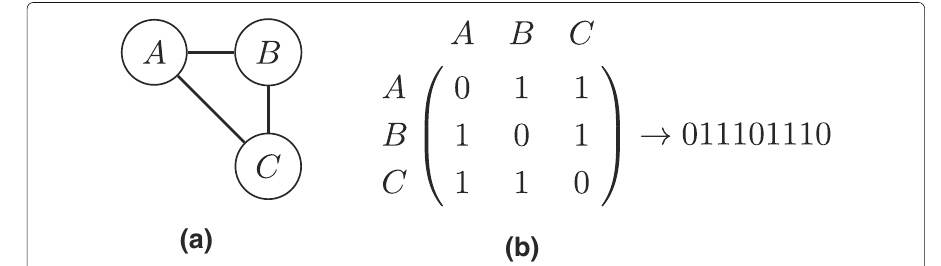
Fig. 3 Pattern labeling. a Undirected graph, b Label of this